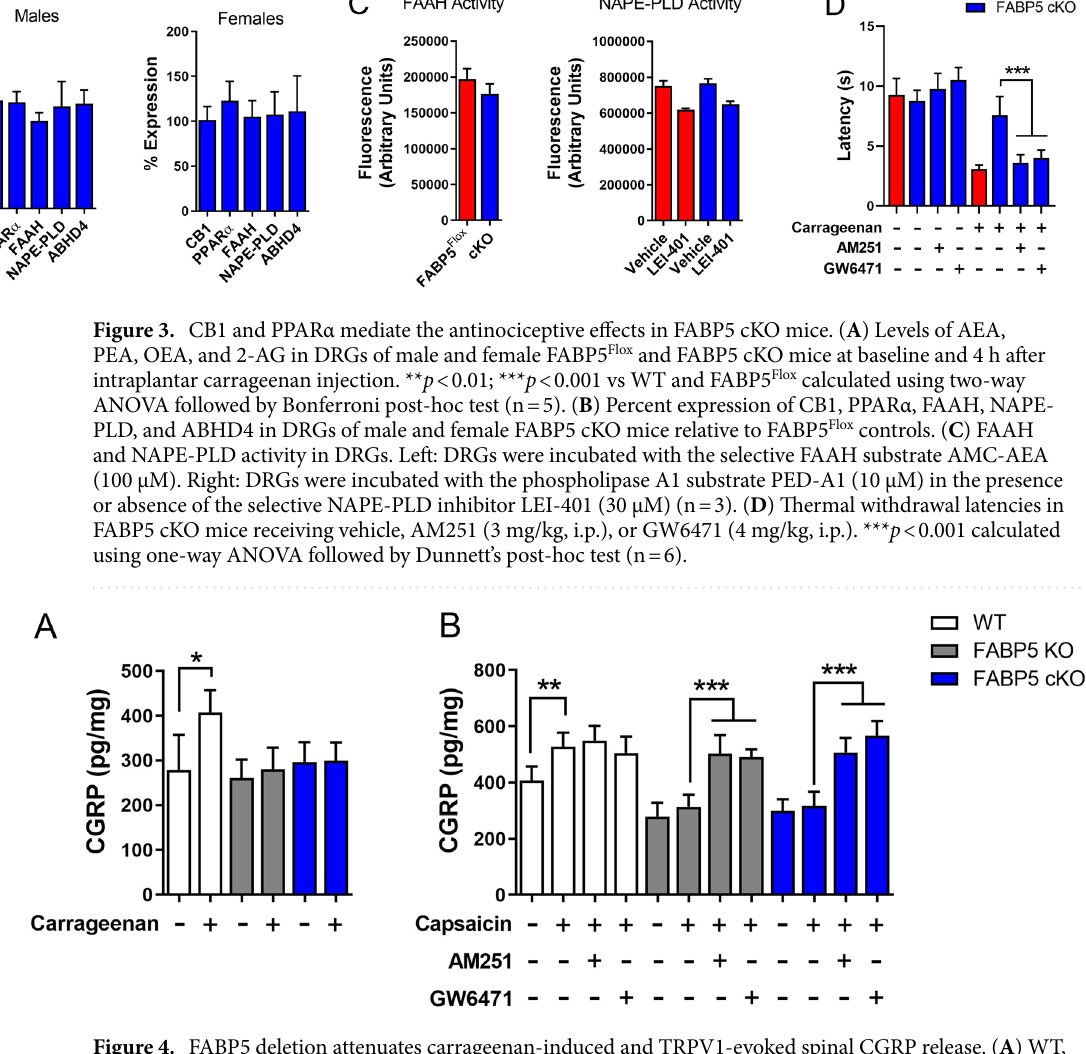
Figure 4. FABP5 deletion attenuates carrageenan-induced and TRPV1-evoked spinal CGRP release. ( A ) WT, FABP5 KO, and FABP5 cKO mice received intraplantar injections of vehicle or carrageenan and lumbar spinal cords were obtained 4 h later. The sections were incubated for 30 min and CGRP release was subsequently quantified. * p < 0.05 calculated using unpaired t test (n = 5). ( B ) WT, FABP5 KO, and FABP5 cKO mice were administered vehicle, 3 mg/kg AM251, or 4 mg/kg GW6471 prior to intraplantar injections of carrageenan. Lumbar spinal cord sections were collected 4 h later and incubated with vehicle followed by 1 µM capsaicin in the presence or absence of 3 µM AM251 or 10 µM GW6471 for 30 min. CGRP release was quantified prior to and after the addition of capsaicin. ** p < 0.01; *** p < 0.001 calculated using one-way ANOVA followed by Dunnett’s post-hoc test (n =